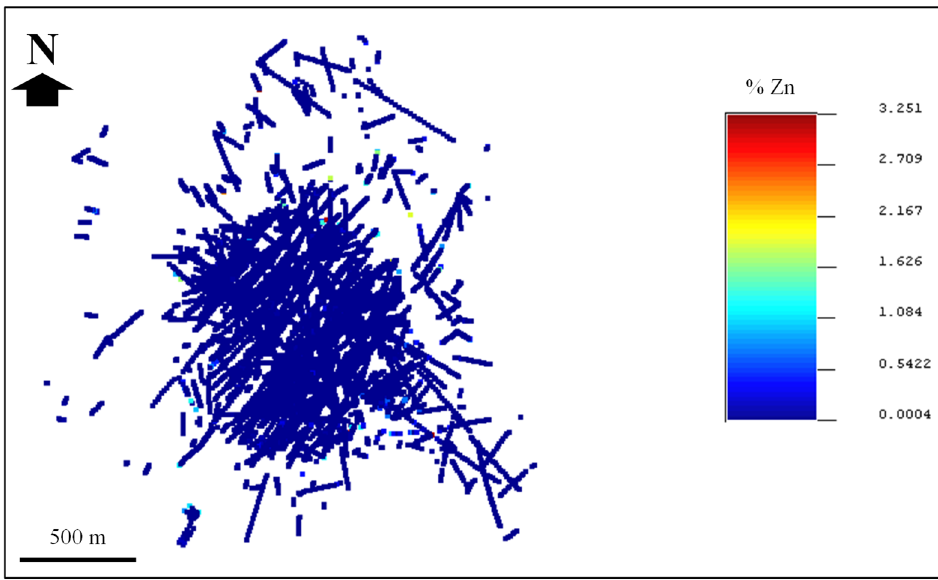
Figure 1. Top view of drill hole pattern composed of zinc grades (% weight) in a porphyritic system associated with skarn orebodies (modified from [10]).